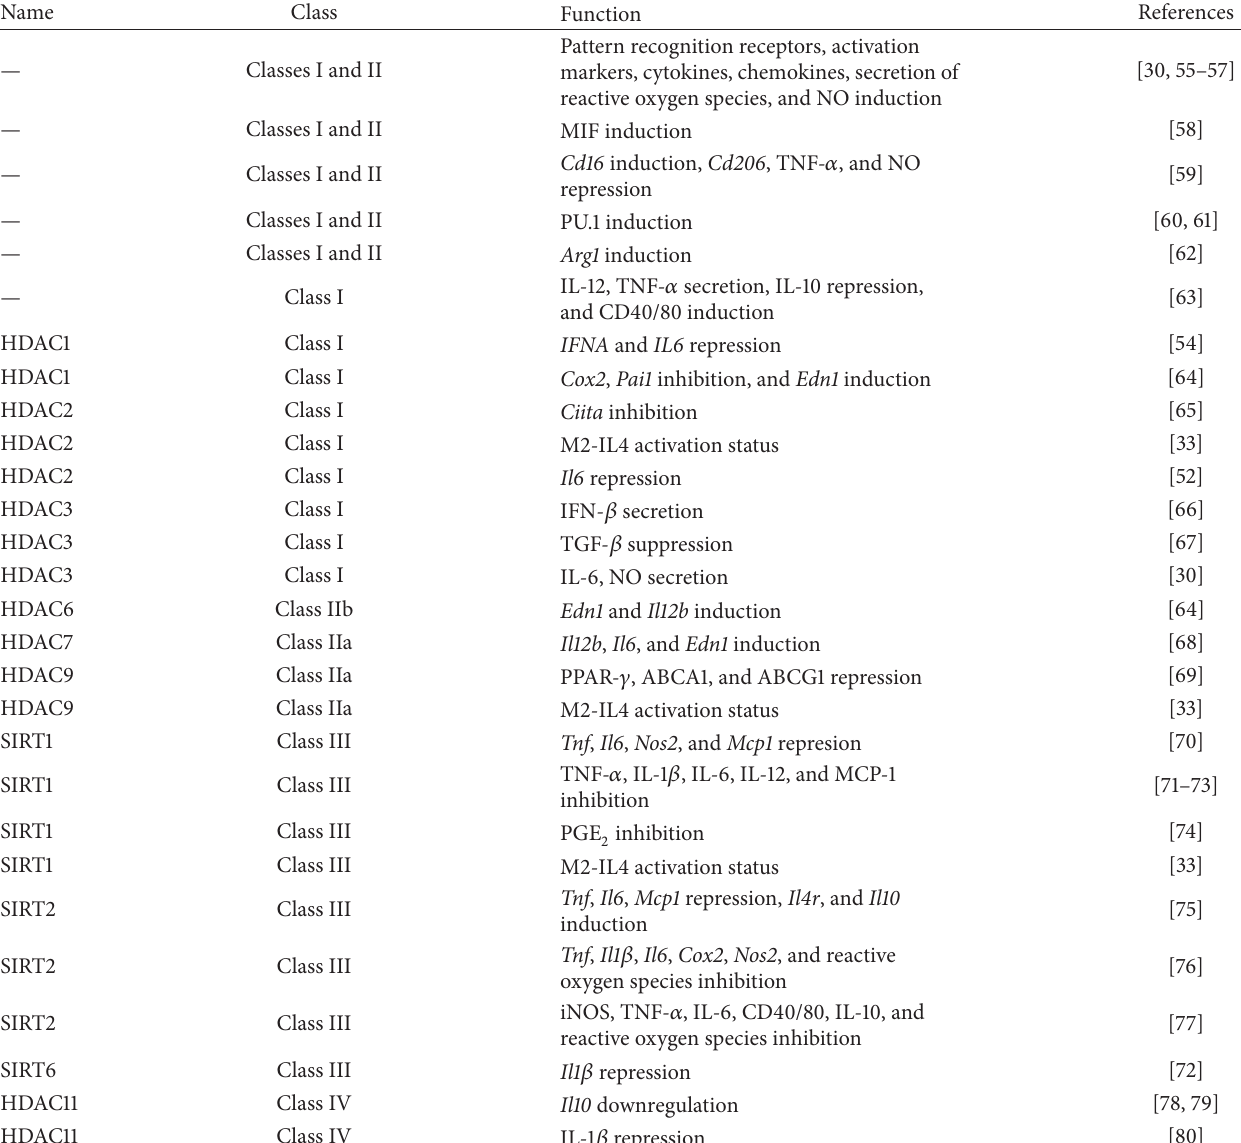
Table 4: HDACs involved in macrophage